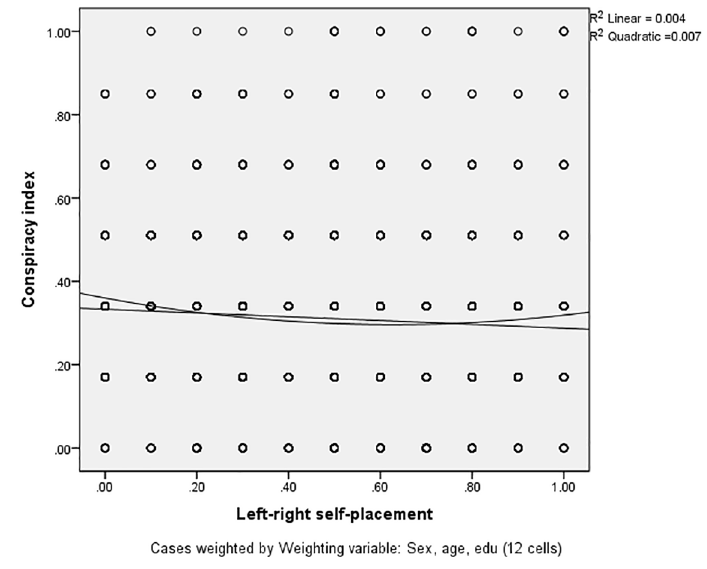
Figure 1. Linear and quadratic relationship between political ideology and belief in conspiracy